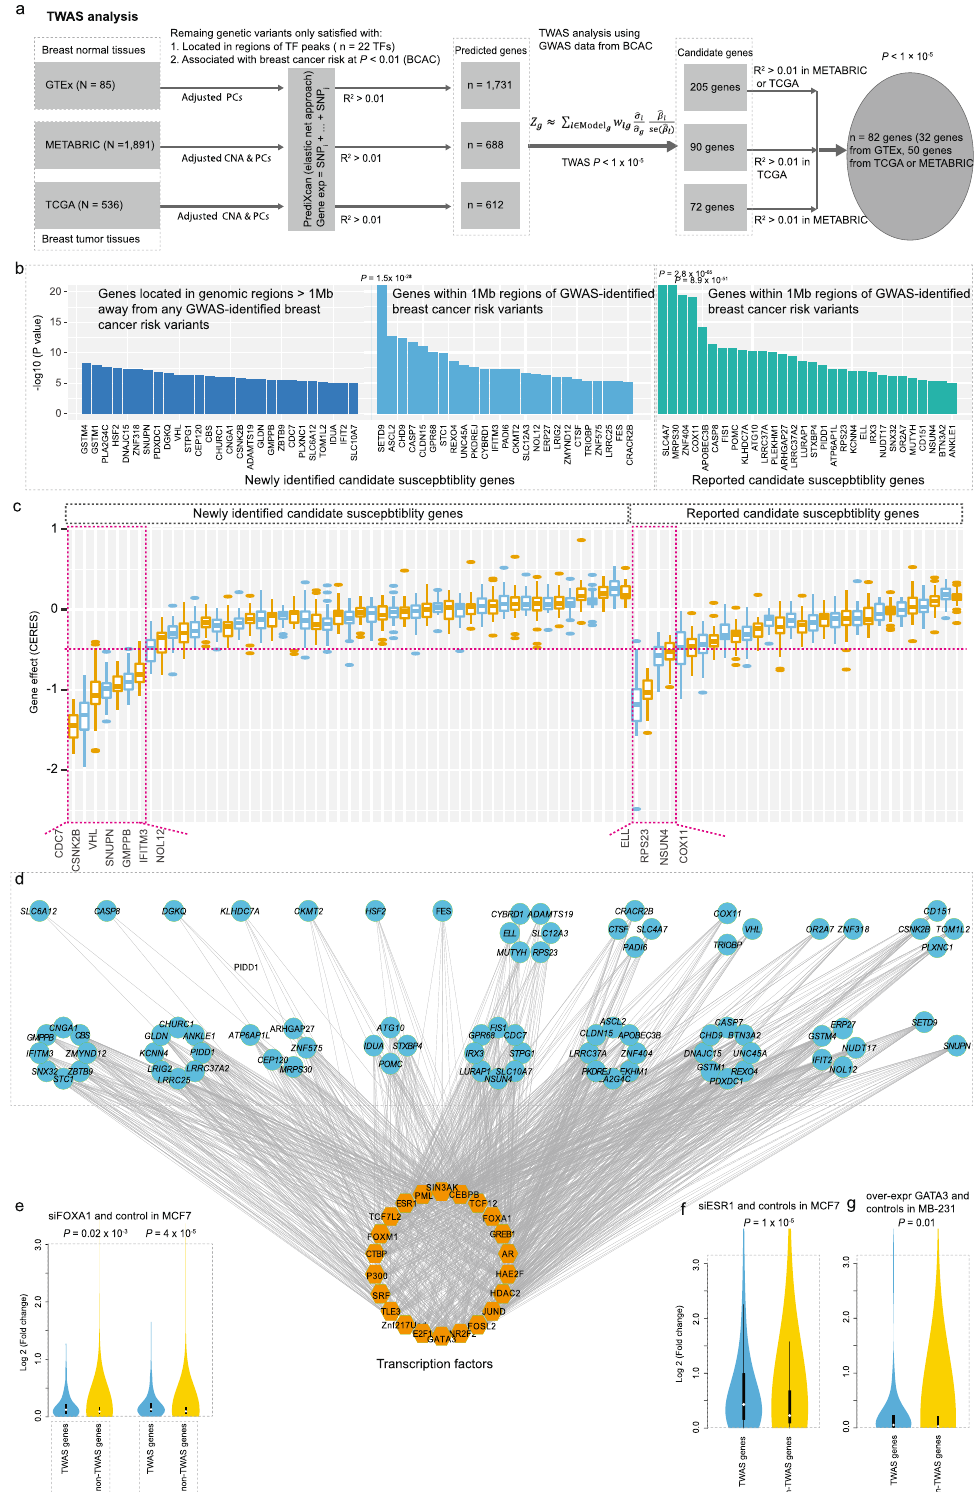
prediction accuracy of the prediction model with cis -genetic variants could be low or compromised if they occur in non- regulatory elements (i.e., not in LD with regulatory variants), or if they disrupt binding sites of non-transcribed TFs in target tissues. In addition, LD among genetic variants used in the gene pre- diction models induces signi fi cant gene-trait associations at nearby non-causal genes in the region, leading to false-positive